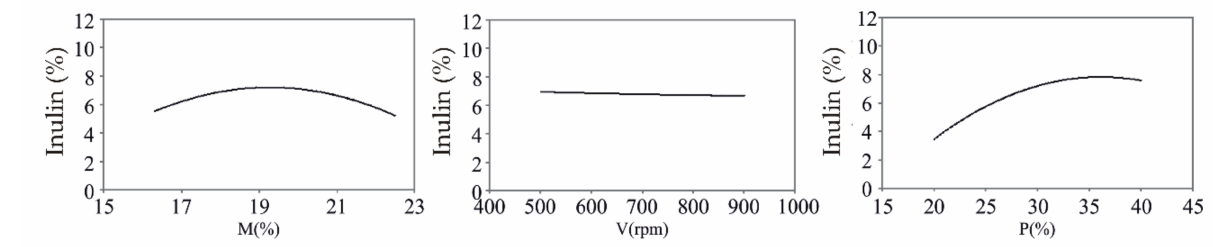
Figure 1. Influence of extrusion conditions (M—moisture content; V—screw speed; P—chicory